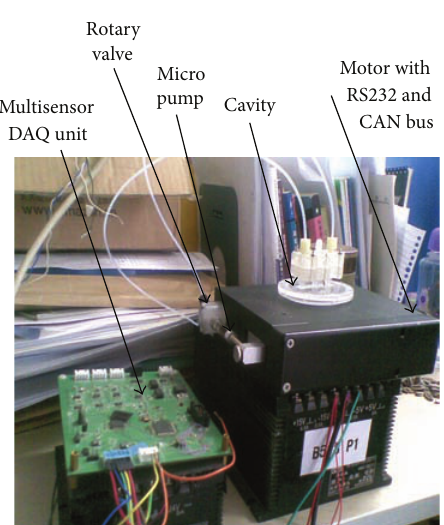
Figure 15: A photograph of micro pump and multisensor data acquisition